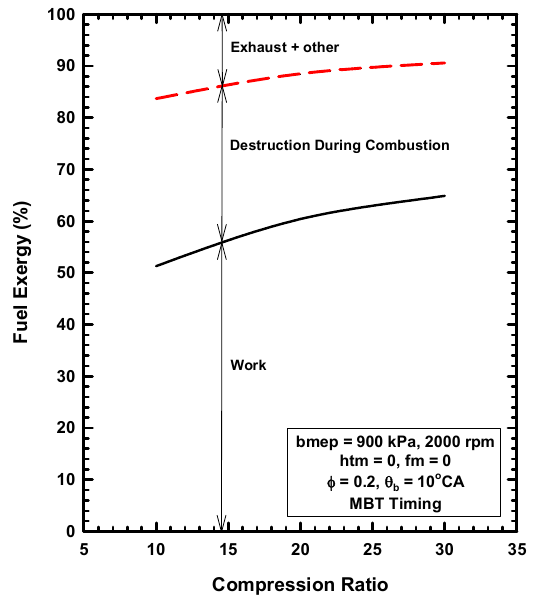
Figure A2. Partition of the fuel exergy among work, destruction, exhaust, and other items as a function of compression ratio for the ideal conditions.